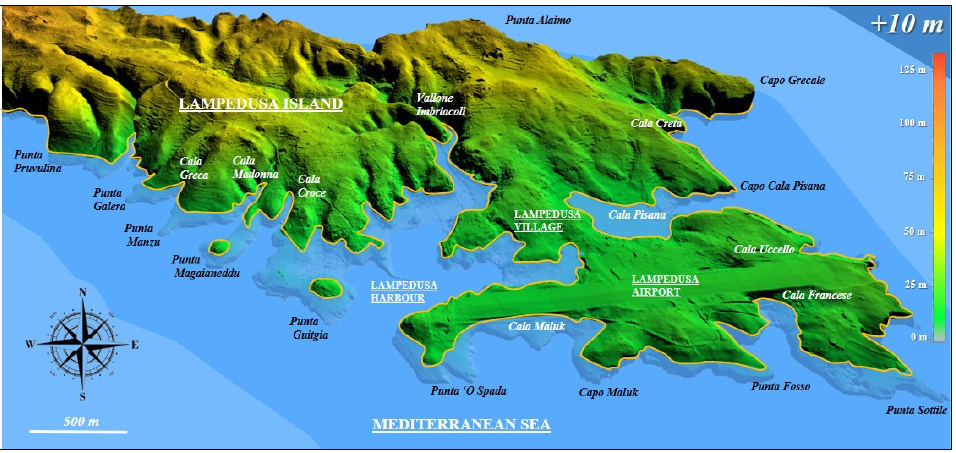
Figure 9. 3D flooding map (+10 m) along the southeastern sector of the island of Lampedusa.